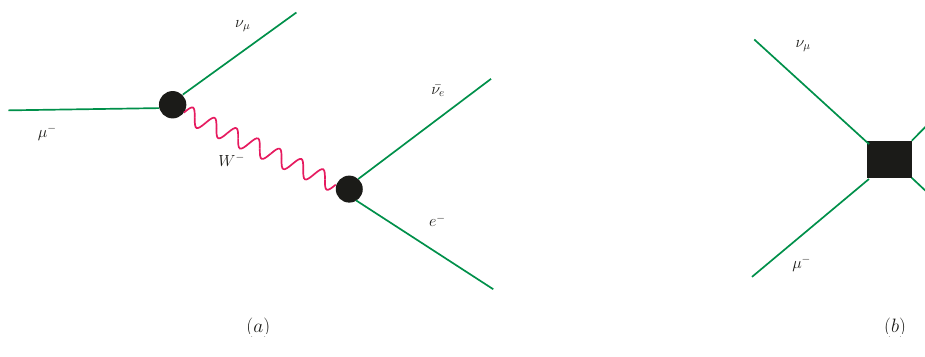
Figure 6. Three-body decay of muon: (cid:22) (cid:0) e (cid:0) + (cid:22) (cid:23) e + (cid:23) (cid:22) . This process gives an estimation ! for Fermi constant ( ). The (a) [ ] depicts the modi(cid:12)ed Feynman vertex (renormalizable + (cid:15) G F corrections due to dimension-6 operators), and (b) [ (cid:4) ] represents the e(cid:11)ective four-Fermi vertex.